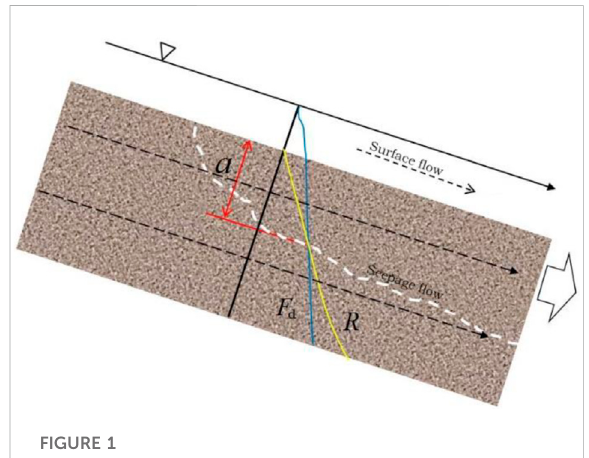
FIGURE 1 General diagram of movable solid materials.